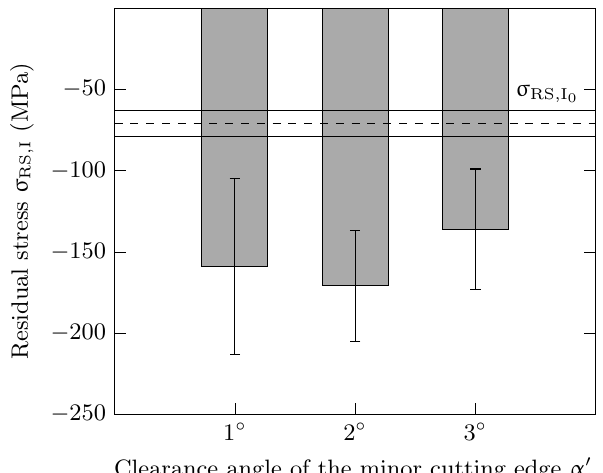
Figure 13. Residual stress σ RS,I for different clearance angles α (cid:48) o of the minor cutting edge ( v c = 250m/min, f z = 0.015mm, a p = 0.25mm, a e = 0.5mm, γ (cid:48) o = 0 ◦ ).